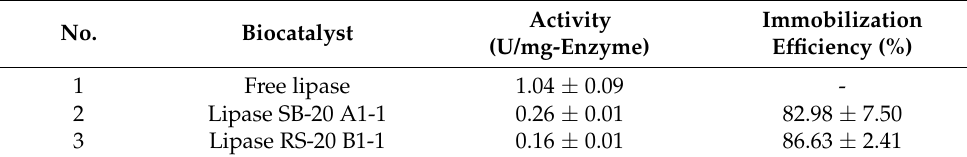
Figure 7. The activity of immobilized enzymes in various CNC modifications was relative to the Table 3. Enzyme activity of the free and immobilized enzyme and immobilization efficiency of lipase activity of free enzymes. Activity testing was carried out at a temperature of 25 °C. on immobilized enzyme using canola